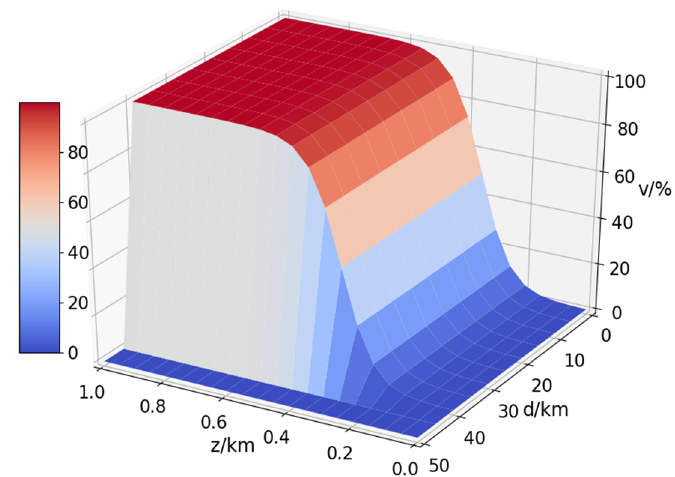
Figure 3. Probability of unmanned helicopter being detected by radar.